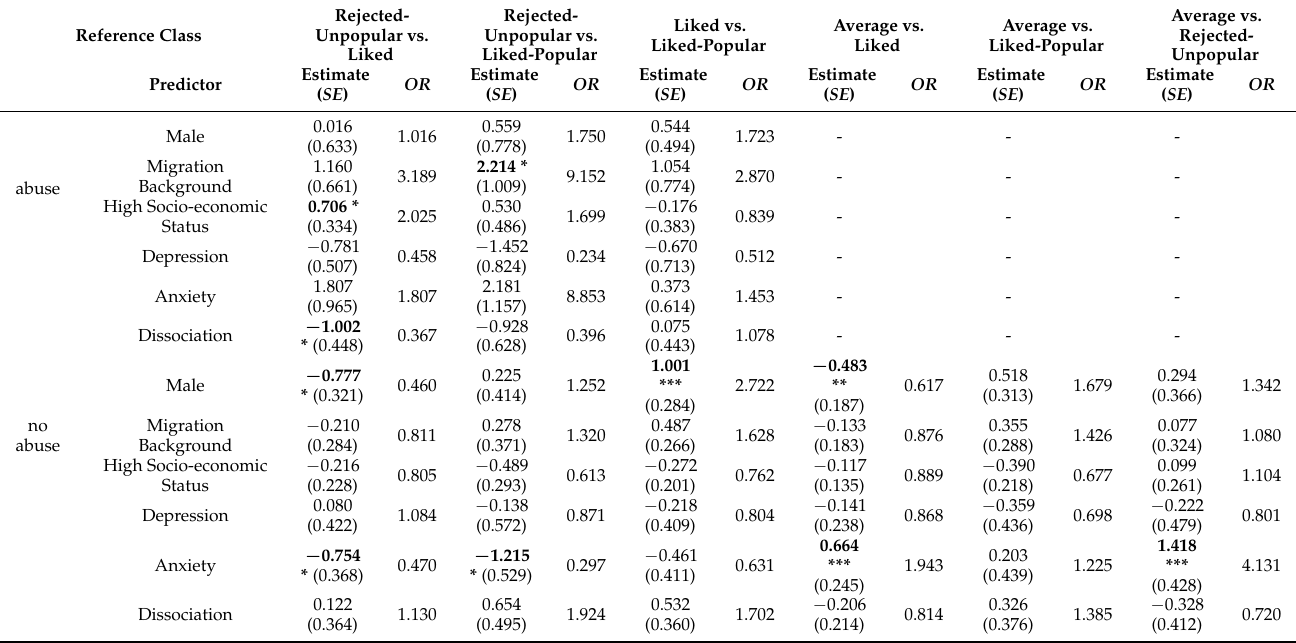
Table 5. Multinomial logistic regression of socio-demographic covariates, depression, anxiety, and dissociation to the identified latent profile membership: parameter estimates of both